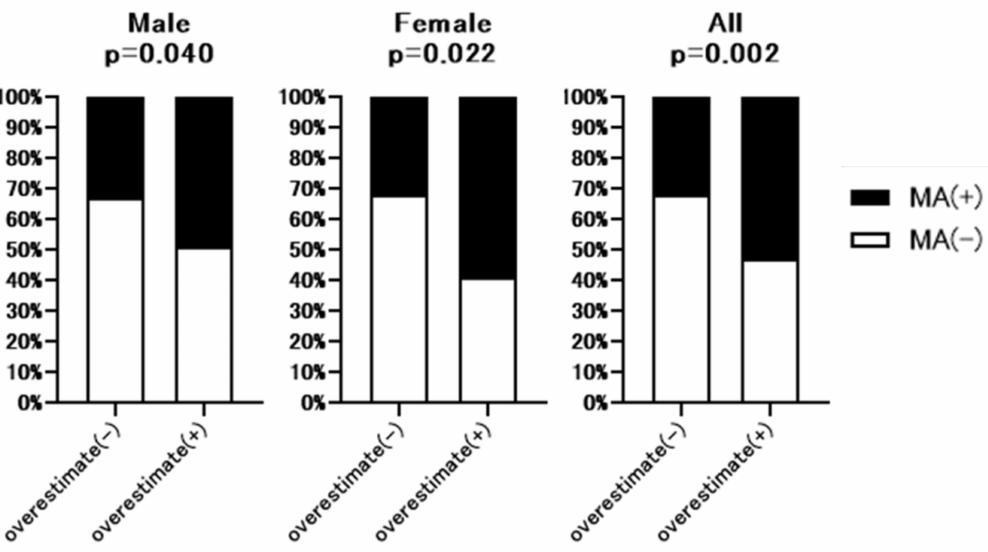
Figure 3. Comparison of the rate of muscle atrophy between patients with or without overestimated renal function. Overestimate ( − ); patients without overestimated renal function. Overestimate (+); patients with overestimated renal function. MA; muscle atrophy. p -value indicates comparison of the Overestimate (+) group vs. Overestimate ( − ) group.